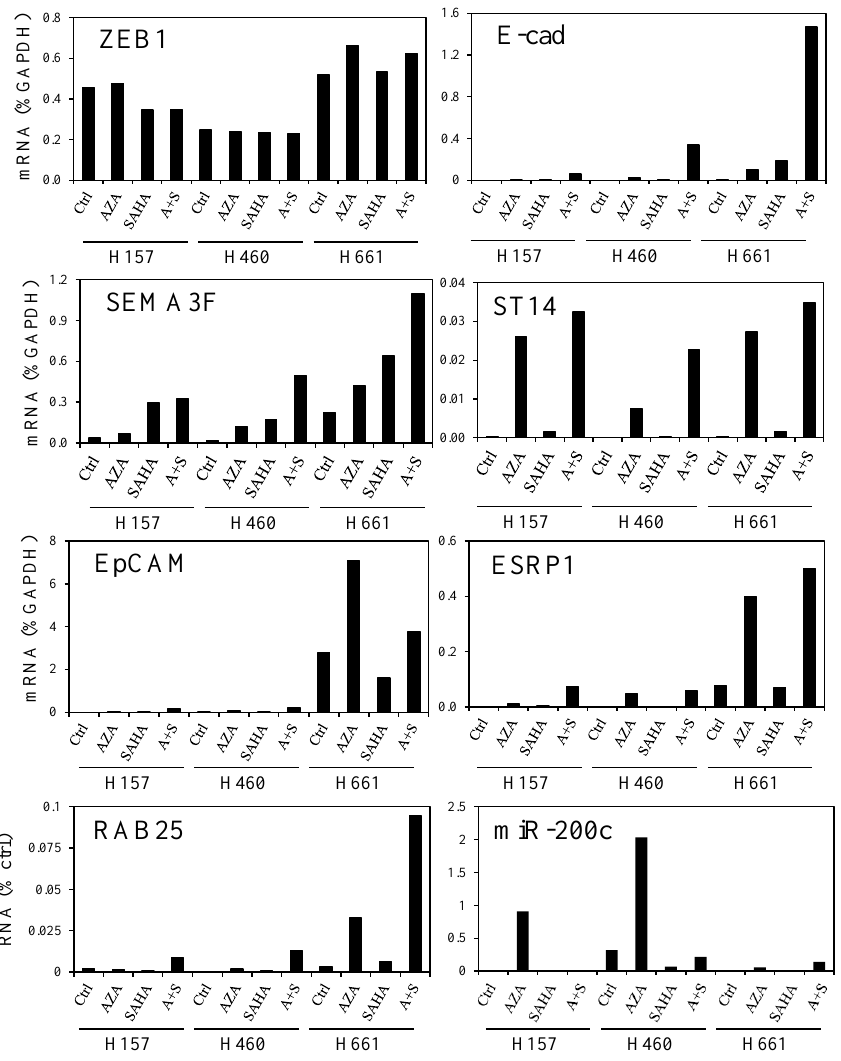
Figure 8. DNA demethylation and histone deacetylase inhibition increase ZEB1 target gene expression. H157, H460, and H661 NSCLC cell lines were treated by AZA, SAHA, and the combination (A + S). Gene expression was measured by qRT-PCR. For mRNA expression, values are expressed as percent of GAPDH, and for miR-200c they are expressed as % of RNU6B. Two independent experiments were performed with qPCR reaction in duplicate and one representative experiment is